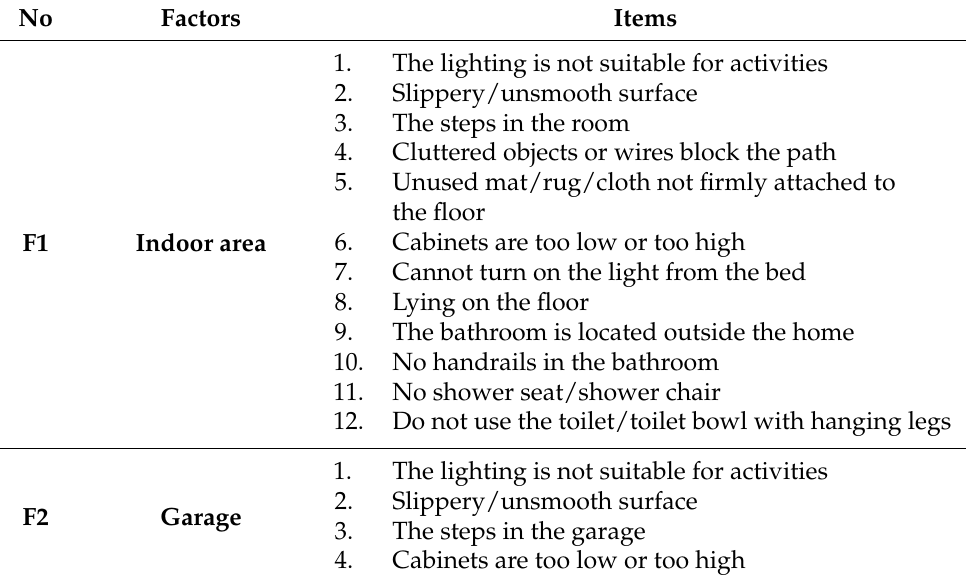
Figure 1. The model of home fall hazards risk. Four factors consisted of F1—indoor area, F2—garage, F3—outdoor area, and F4—risky spots/areas including pets. Table 1. The factors and the items of the Thai-HFHAT-SF.